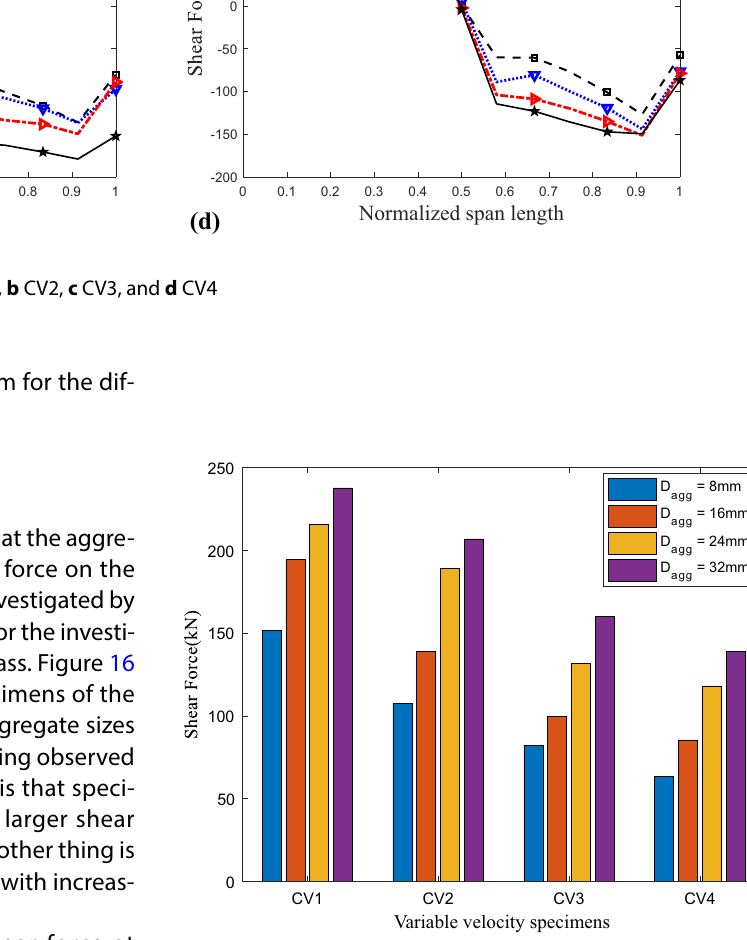
Fig. 17 Average shear force on the critical section under variable impact